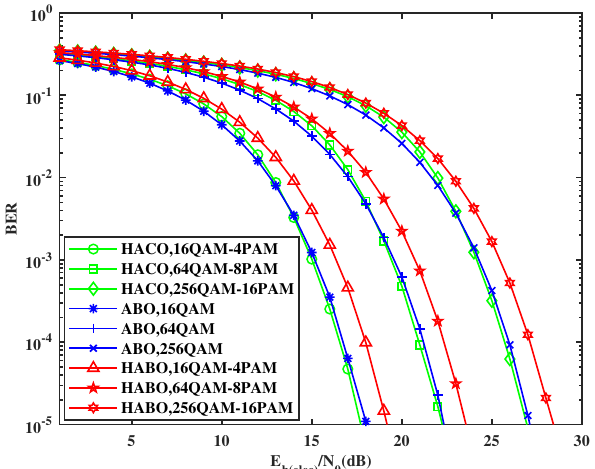
Figure 3. Comparison of the BER performance for HACO-OFDM, ABO-OFDM, and HABO-OFDM. The complementary cumulative distribution function (CCDF) curves of the